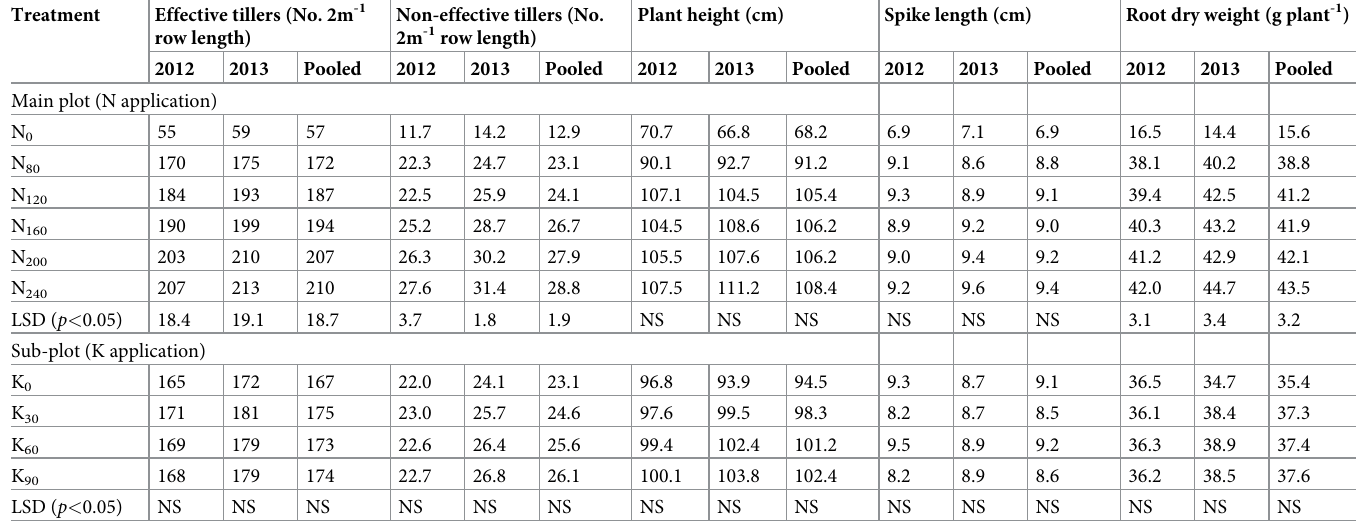
Table 1. Effect of nitrogen (N) and potassium (K) application on yield attributes viz. number of effective tillers, number of non-effective tillers, plant height, spike lengh and root drt weight of wheat ( Triticum aestivum L.) in a sandy loam soil in sub-tropical India. Treatment Effective tillers (No. 2m -1